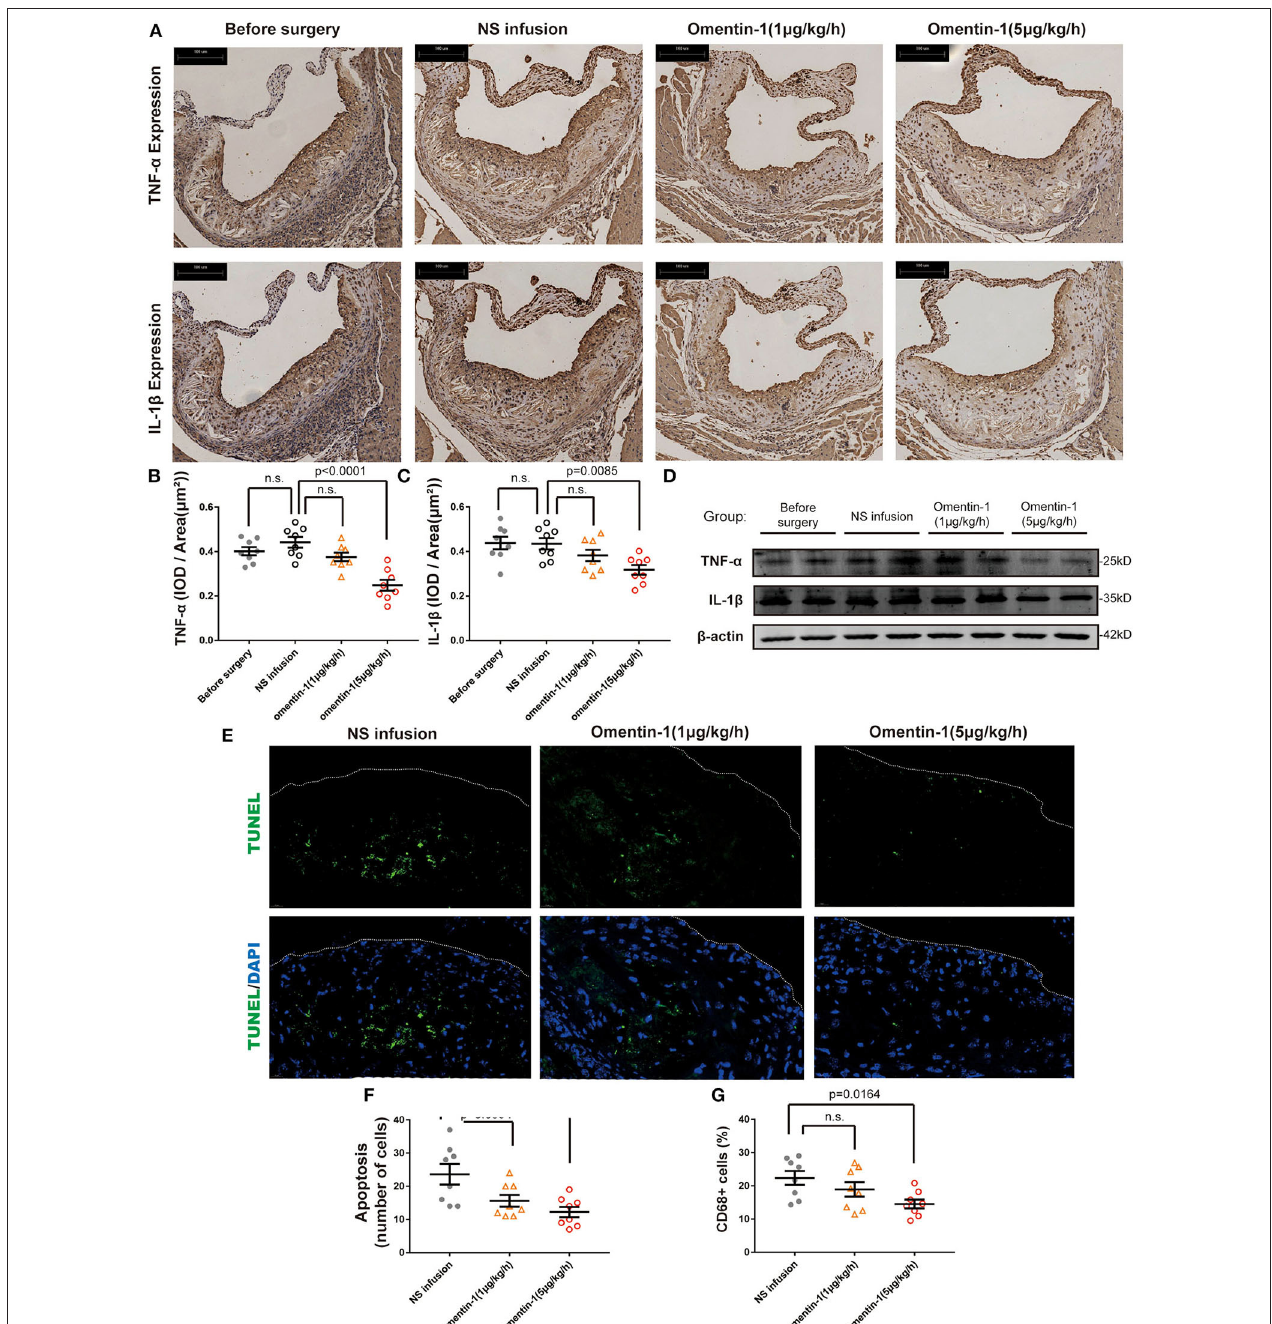
FIGURE 2 | Omentin-1 infusion reduces inflammatory cytokines expression and cell death in atherosclerotic plaque of ApoE − / − mouse. (A) Representative micrographs of the aortic root sections of ApoE − / − mice stained by the antibodies against IL-1 β or TNF- α . (B,C) Graph shows the intensity of inflammatory cytokines expression (n 1,2,3,4 = 8). The results of immunohistochemistry analysis were expressed in the integral optical density (IOD) of positive staining area vs. plaque area [(IOD, sum)/(Plaque area, µ m 2 )]. (D) Aortic root samples were collected from animal models and the expression of TNF- α and IL-1 β were quantified by western blot analysis. (E) Representative images of the aortic root sections of the mouse were stained by DAPI (Abcam, ab104109, displayed in blue) and the apoptotic cell was detected by TUNEL staining (green). The plaque area was marked by a dot line. (F) The graph shows the cells undergoing apoptosis in the AS lesion. The intensity of apoptosis was quantified by counting the apoptotic cells (TUNEL + cells) in each sample (n 1,2,3,4 = 8). (G) The macrophage infiltration in each sample was quantified by calculating the proportion of CD68 positive area (CD68 + area/ total plaque area, n 1,2,3,4 = 8). All the data in this figure were presented as mean ± SEM [n.s., non-significant; n 1 , the number of subjects in before surgery group; n 2 , the number of subjects in NS infusion group; n 3 , the number of subjects in group infused with omentin-1 (1 µ g/kg/h); n 4 , the number of subjects in group infused with omentin-1 (5 µ g/kg/h)].